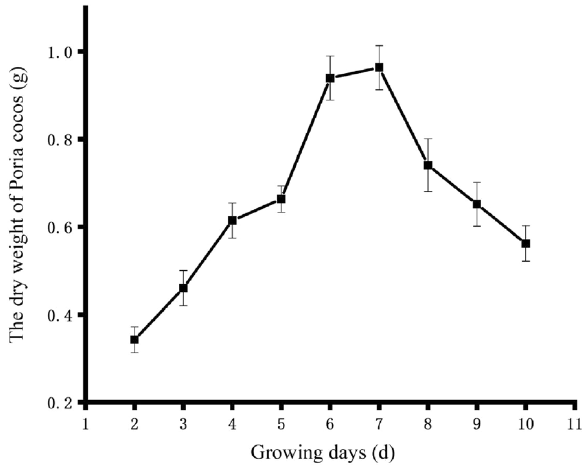
Figure 1. Growth curves of Poria